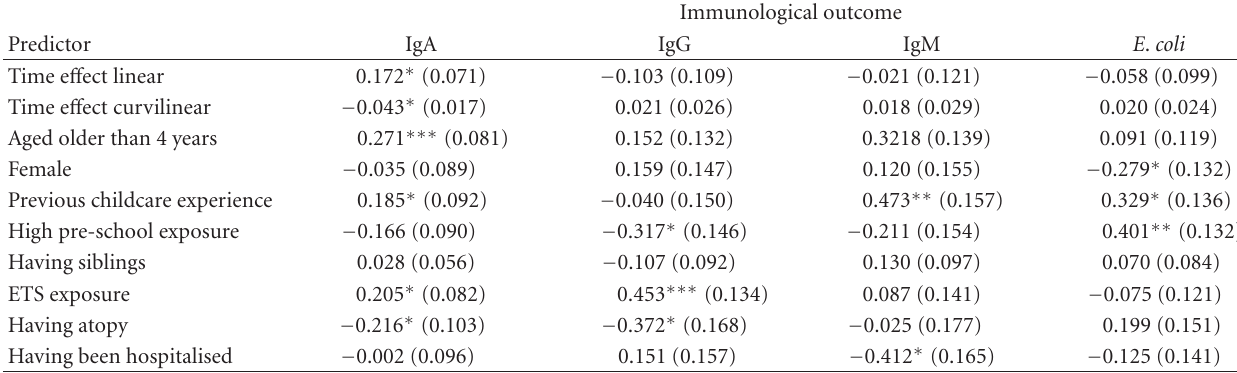
Table 3: Regression coe ffi cients (standard errors in parentheses) for multilevel regressions on each immunological outcome. Immunological